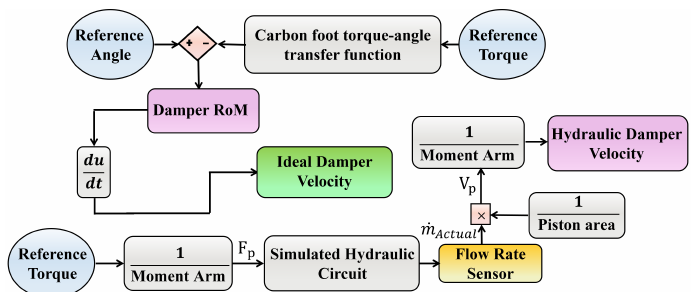
Figure 6. The flowchart algorithm for determining the rotary flow control valves’ diameter range for operating in the simulated hydraulic circuit and optimal diameter to adjust optimal flow